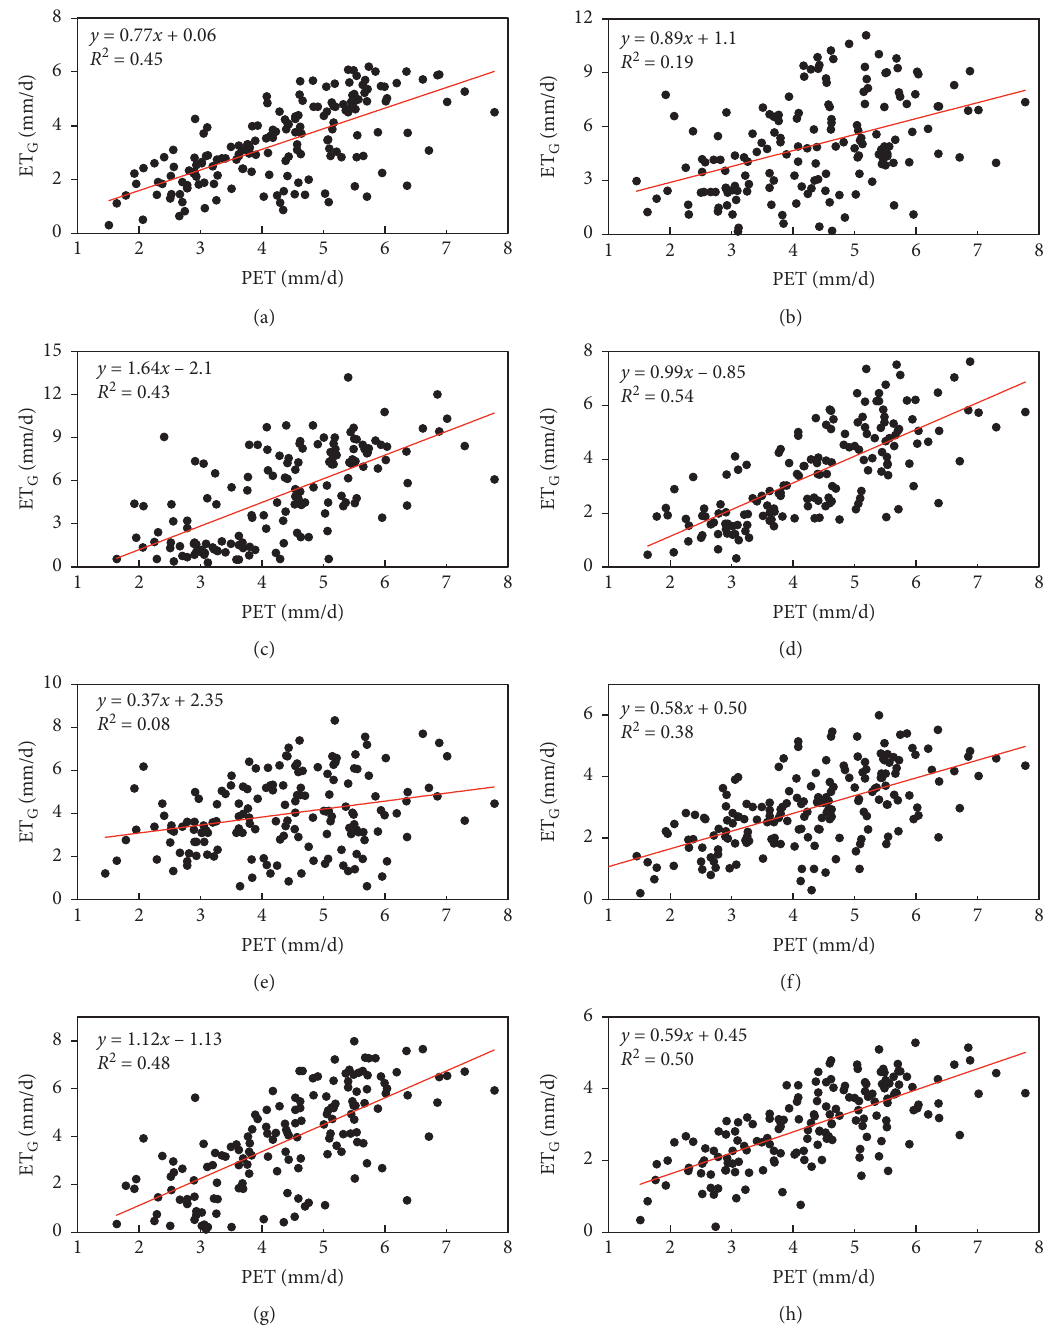
Figure 7: Relationship between the estimated daily groundwater evapotranspiration (ET G ) and potential evapotranspiration (PET) at the eight observation sites with vegetation coverage. (a) G3, Phragmites australis (DTWT: 0.74–1.05 m). (b) G4, Phragmites australis (DTWT: 0.83–1.45m). (c) G5, Phragmites australis (DTWT: 0.75–1.45m). (d) G6, Achnatherum splendens (DTWT: 0.97–1.15m). (e) G7, Ach- natherum splendens (DTWT:1.19–1.55m). (f) G8, Nitraria tangutorum and Achnatherum splendens (DTWT:1.27–1.39m). (g) G9,